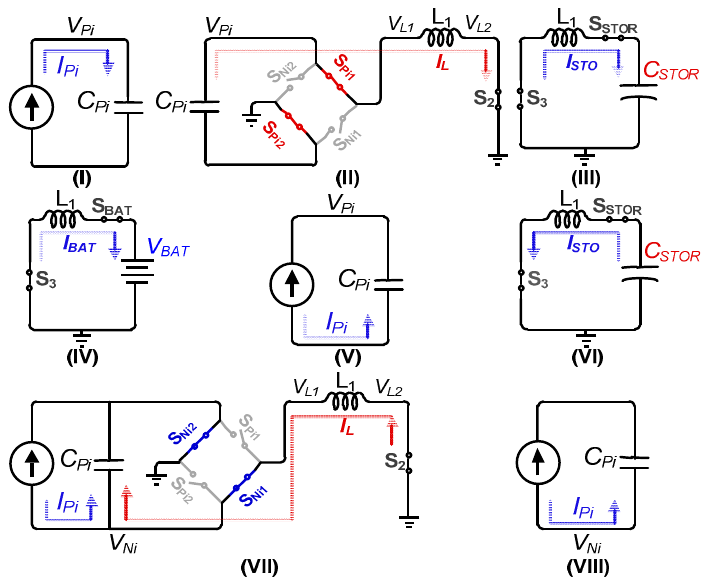
Figure 4. Operation phases of PZT energy-harvesting interface while activating only PZT 1 : ( I ) Positive I Pi charging C Pi until V Pi peaks, ( II ) C Pi drains into L 1 , ( III ) L 1 transfers energy to C STOR , ( IV ) L 1 drains into BAT, ( V ) Negative I Pi charging C Pi only, ( VI ) C STOR transfers energy to L 1 , ( VII ) L 1 transfers energy to C Pi (energy investment), and ( VIII ) Negative I Pi , charging C Pi until V Ni peaks.